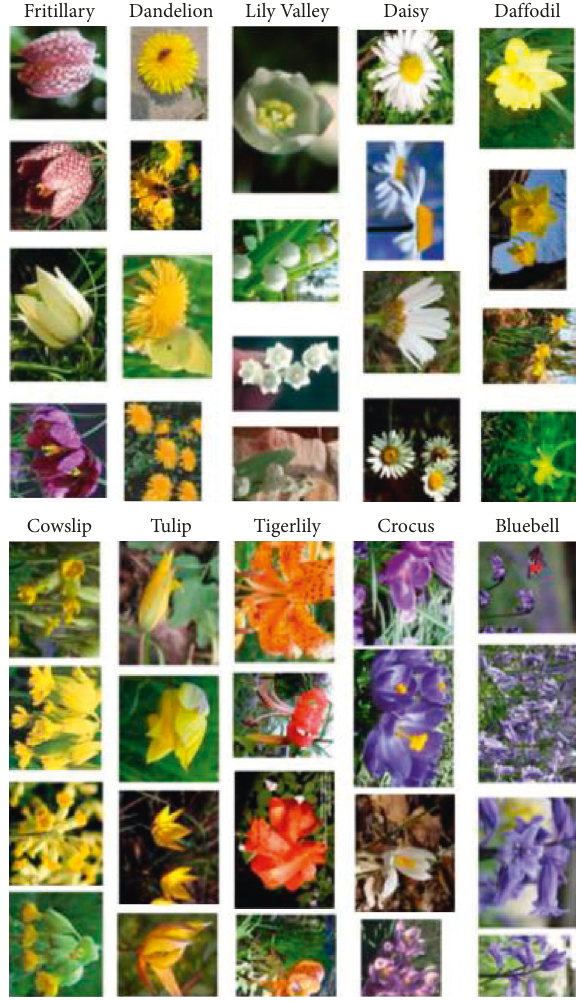
Figure 11: partial image of the Flower dataset [22].